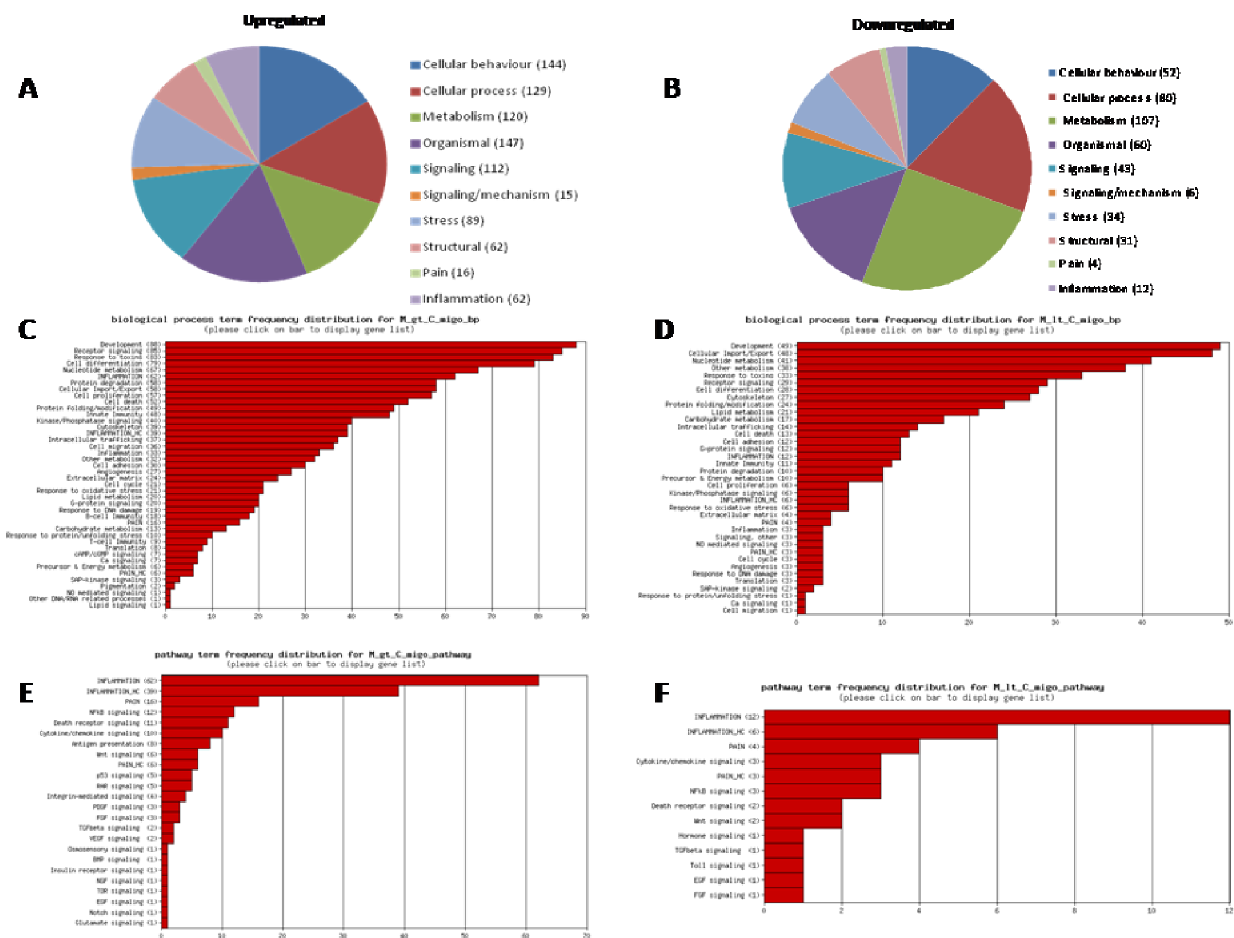
Figure 5. Functional analysis of the effect of VSL # 3 on NMS-induced alteration of gene expression. (A–B) Pie charts representing biological processes, molecular functions and cellular components among differentially expressed genes. (C–D) Frequency distribution of the annotations for upregulated and downregulated genes respectively. Note that in animals treated with probiotic diet there were more genes belonging to the annotations ‘‘Pain’’ and ‘‘Inflammation’’ that were downregulated than those upregulated. (E–F) Frequency distribution of the signaling pathways for upregulated and downregulated genes respectively. gt: greater than; lt: lower than; migo_bp: gene ontology (GO) curated by Miltenyi Bioinformatics biological processs/function; migo_pathways: gene ontology (GO) curated by Miltenyi Bioinformatics pathways; Inflammation_HC: list of genes associated with inflammation from GO data but with more stringent selection criteria; Pain_HC: list of genes associated with pain from GO data but with more stringent selection criteria.